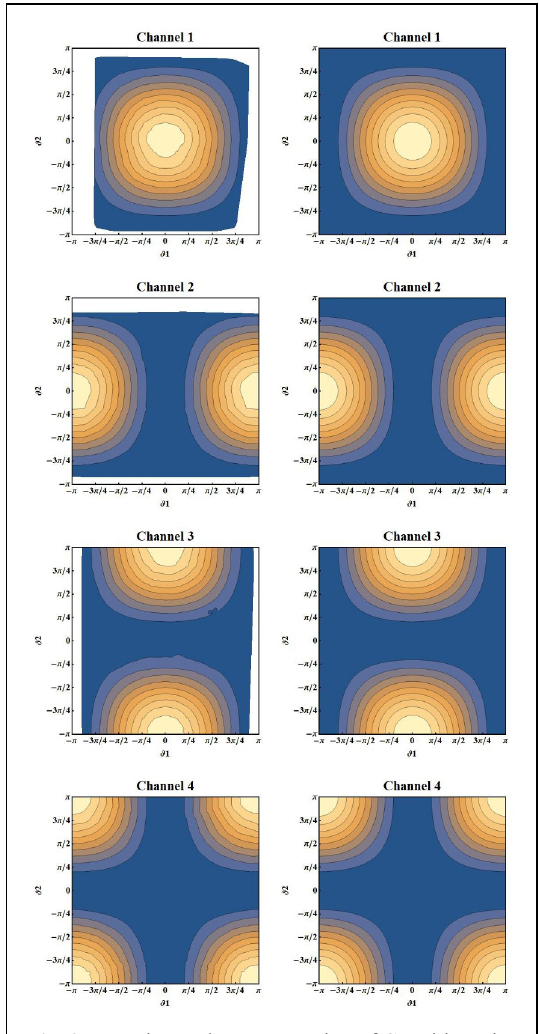
Fig. 2. Experimental Demonstration of Cognitive Bias (Left: Experimental results. Right: Theory)